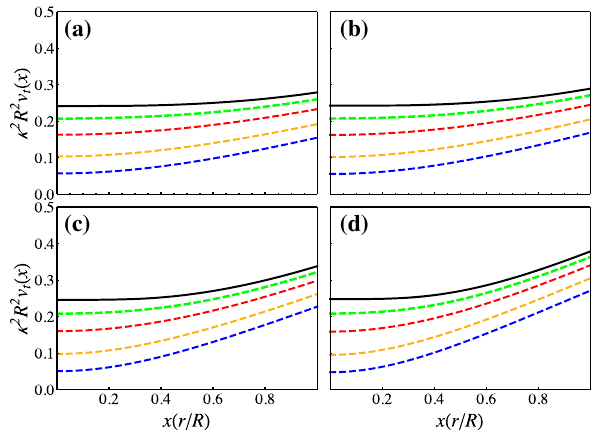
Fig. 9 Adiabatic index, γ , a) u = 0 . 13, b) u = 0 . 15478, c) u = 0 . 2035, d) u = 0 . 229365. α = 0 (black solid line), α = 0 . 04, (green dashed line), α = 0 . 1 (red dashed line), α = 0 . 2 (yellow dashed line), α = 0 . 3 (blue dashed line)